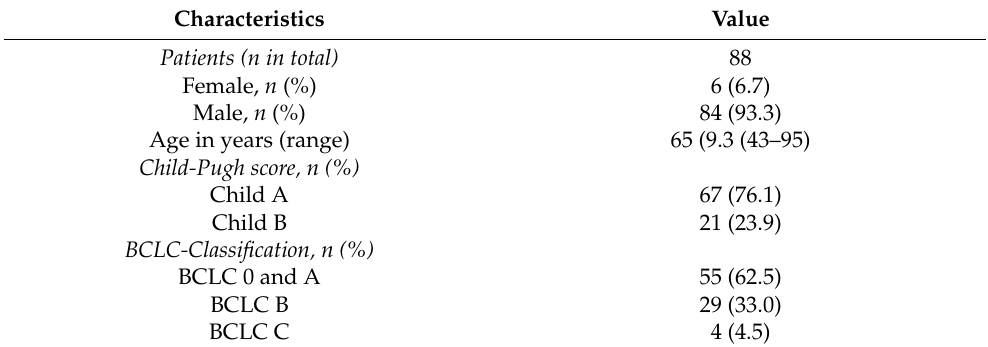
Table 1. Characteristics of 88 patients with a total of 127 HCC lesions treated with stereotactic MWA. Characteristics